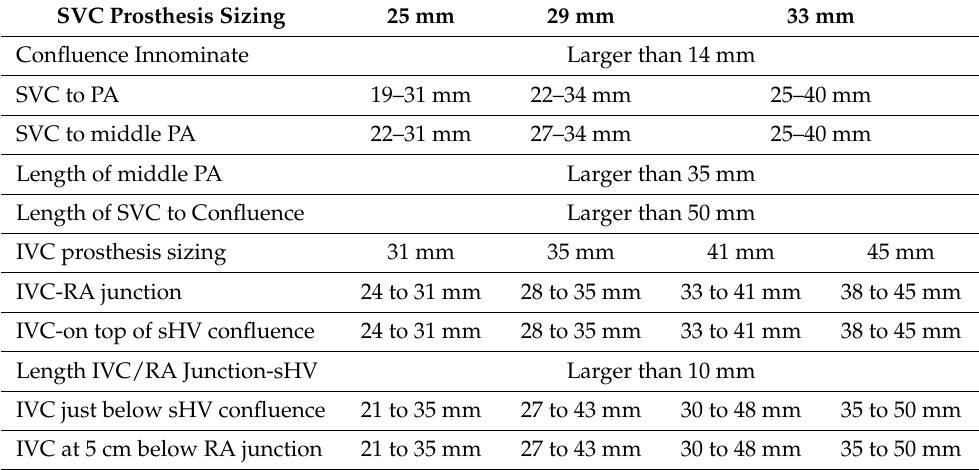
Table 4. Anatomical criteria for currently available TricValve ®